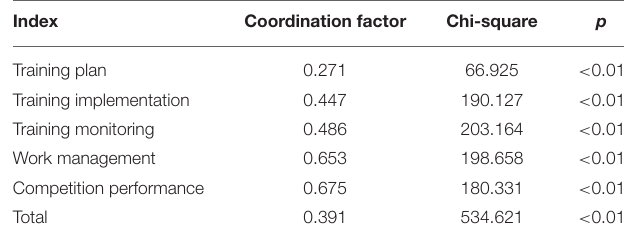
TABLE 6 | Second round of expert coordination factor